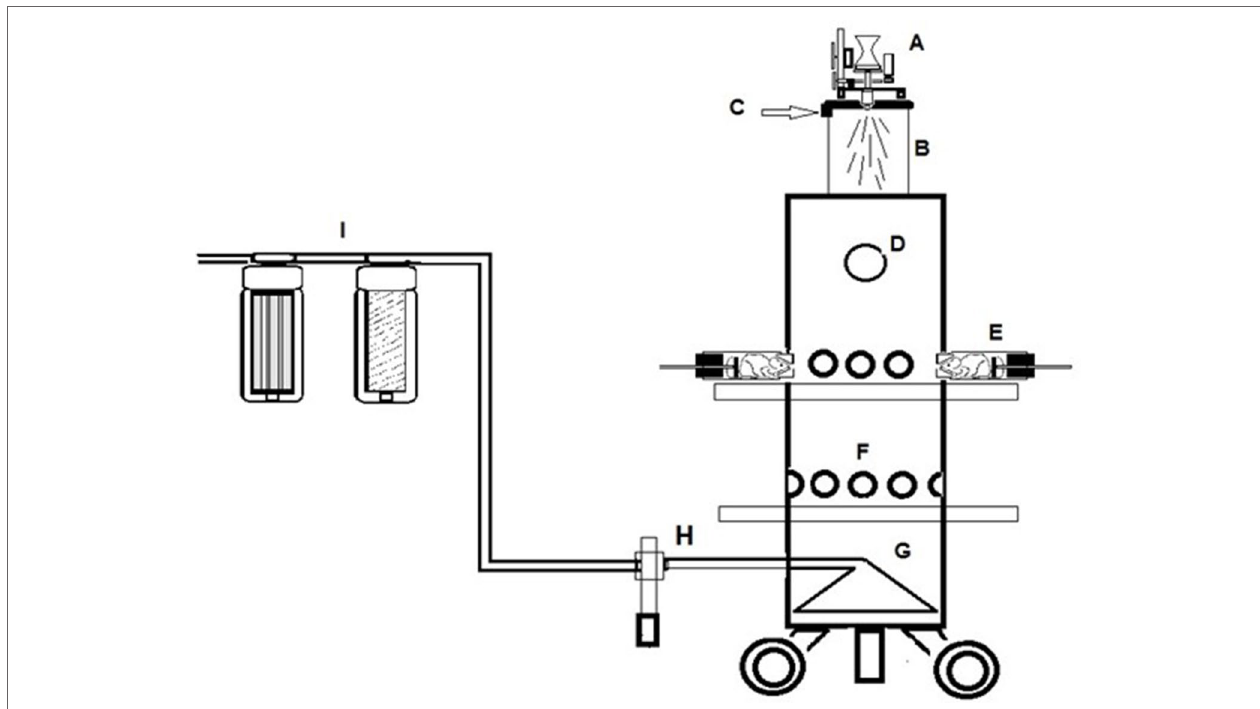
FIGURE 2 | A schematic of the Chiesi inhalation towers. (A) Wrights Dust Feed. (B) Pre-chamber. (C) Tangential air inlet. (D) Viewing port in top section. (E) Restraint tube attached to the tower. (F) Vacant animal ports closed off with bungs. (G) Conical exhaust plenum. (H) Aerosol monitoring device. (I) Filtration units in extract.